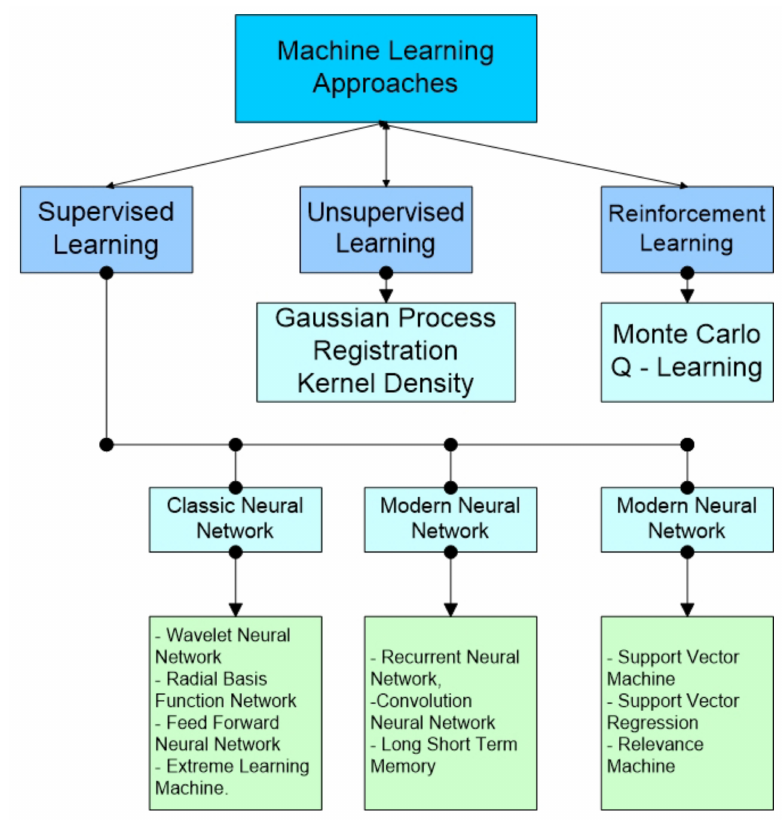
Figure 9. ML approaches in battery